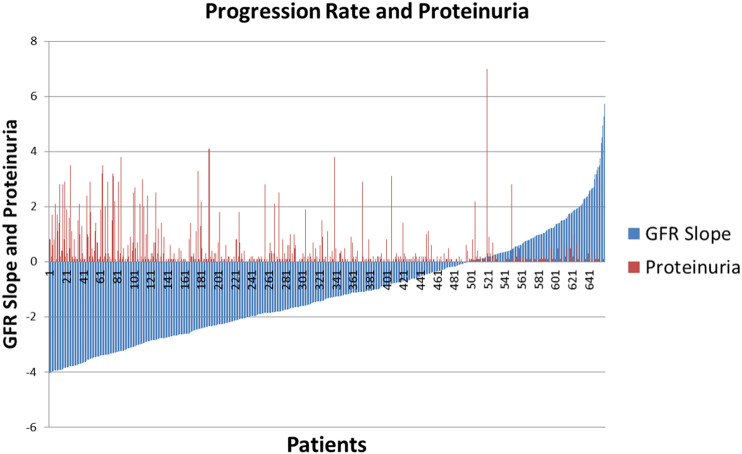
AASK Patients stratified by GFR slope with degree of proteinuria superimposed.